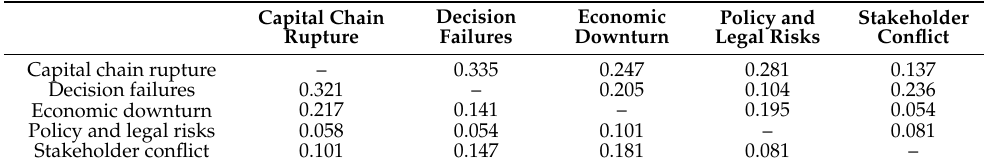
Table 8. Normalized direct-relation matrix M ′ .